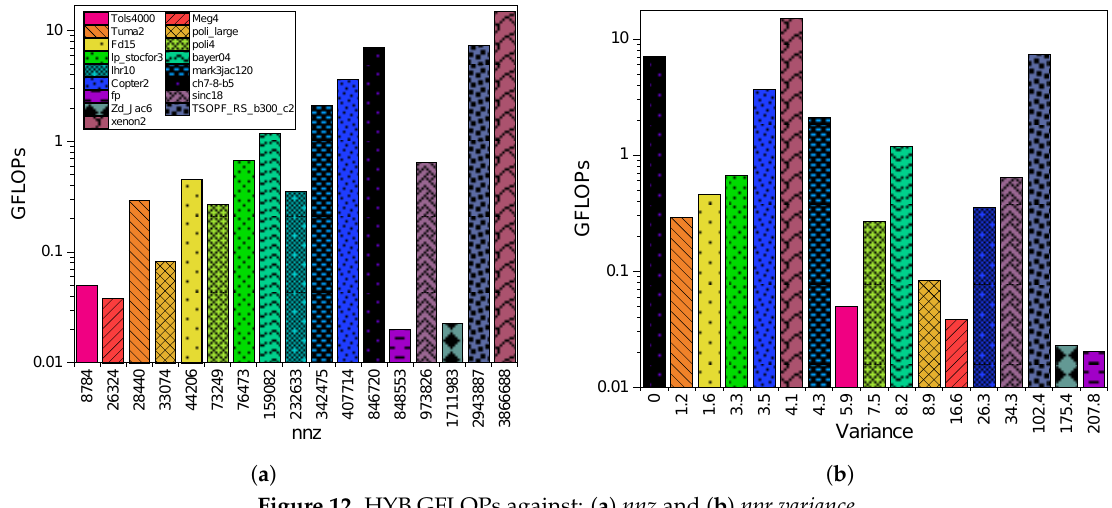
Figure 12. HYB GFLOPs against: ( a ) nnz and ( b ) npr variance